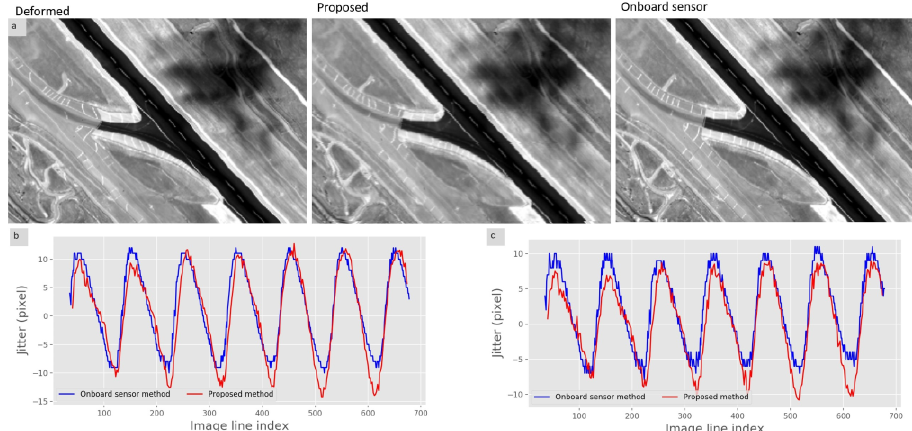
Figure 10. Restoration results on the Yaogan-26 satellite image dataset. ( a ): Restoration results on the Yaogan-26 satellite airport image. From left to right: Raw deformed image; Image restored by RestoreGAN; Image restored by onboard sensors; ( b ): Jitter in the x direction for the two methods; ( c ): Jitters in the y direction for the two methods.